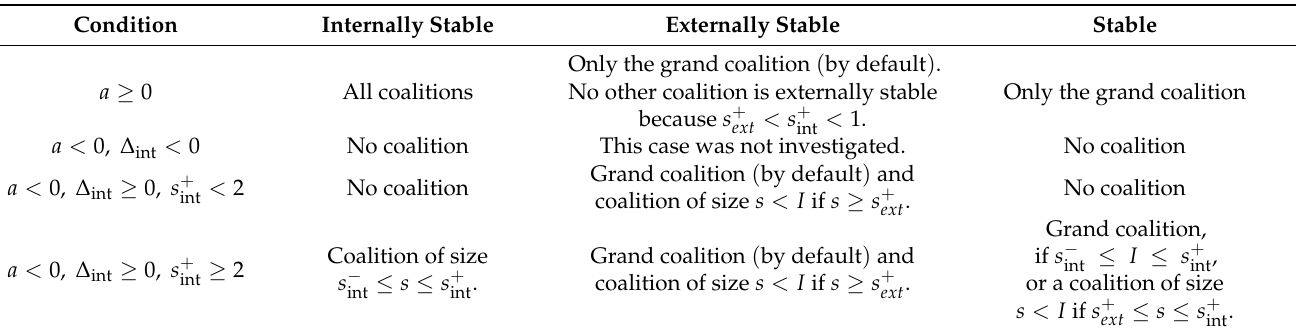
Table 1 Summary of stability conditions. Table 1. collects all the results of this section.